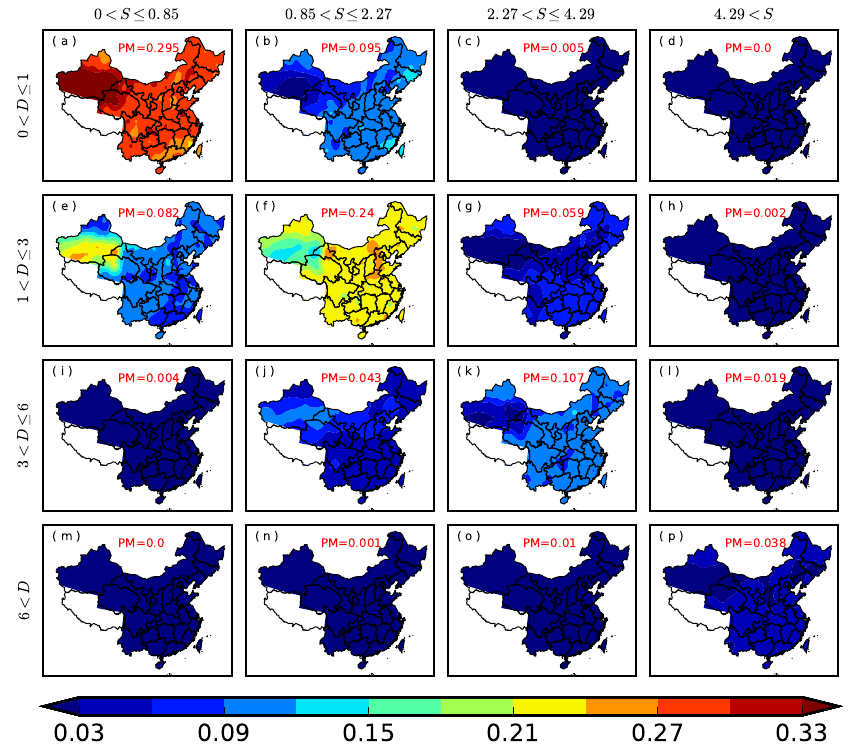
Figure 10. Interval probability based on conventional methods: ( a – p ) represent different drought types.